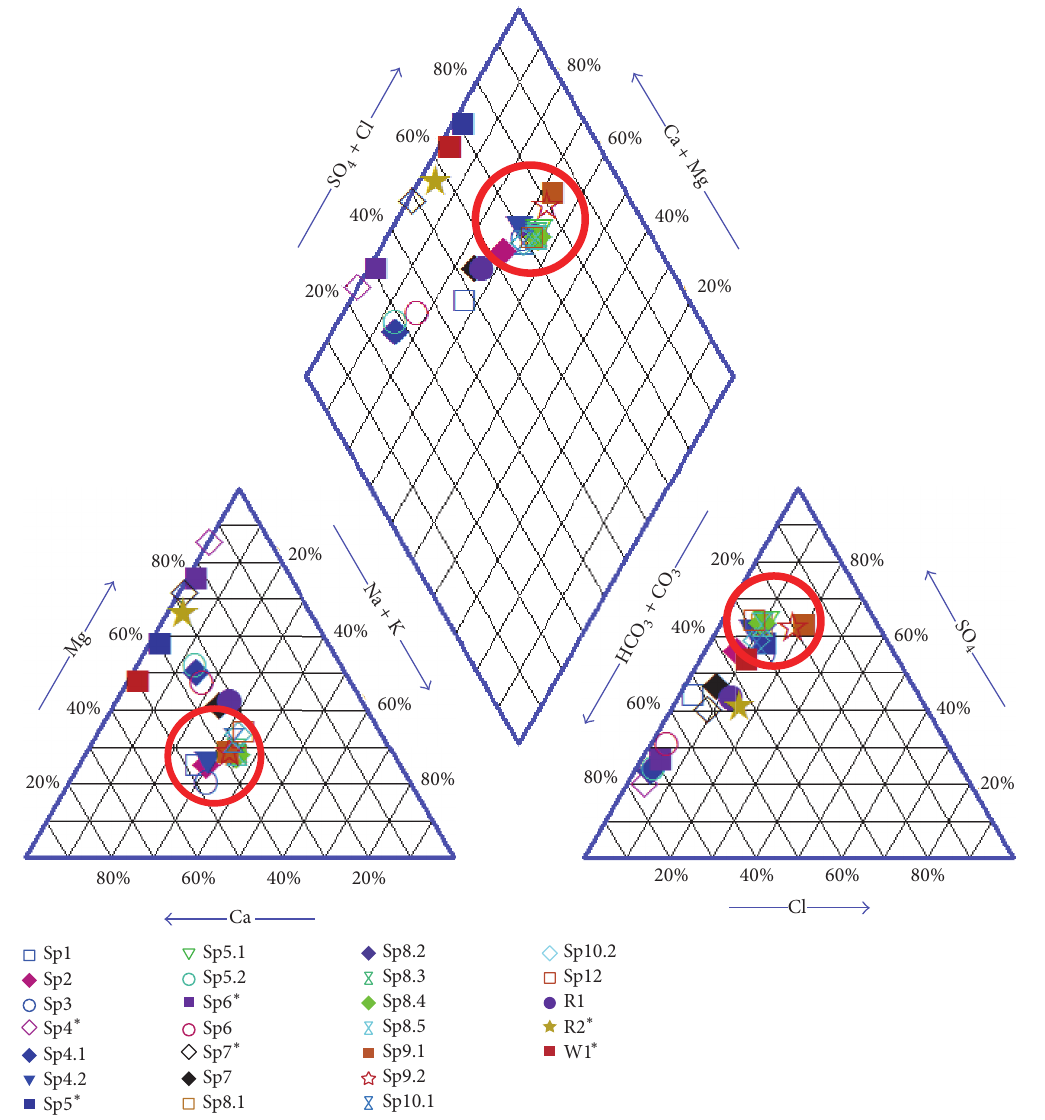
Figure 4: Situation of water samples in the study area on a piper diagram (red circles detect AP and SH hot spring).